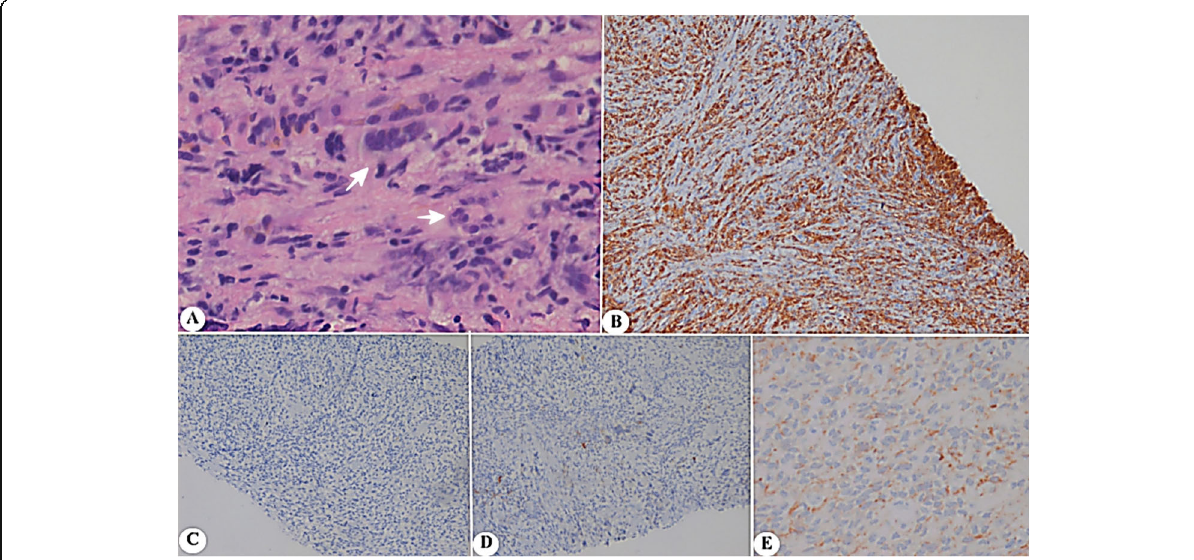
Fig. 3 a Histopathology of the Tru-Cut biopsy specimen from the lesion showing fibroadipose tissue infiltrated by the sheets of foamy histiocytes and Touton-type giant cells (arrows) along with lymphoid cells (hematoxylin and eosin stain; original magnification × 400). Immunohistochemistry showing b diffuse positive staining for CD68 (original magnification × 100), c , d negative staining for CD1a and S-100, respectively (original magnification × 100), and e positive staining for BRAF V600E mutation (Ventana platform immunohistochemistry; original magnification ×